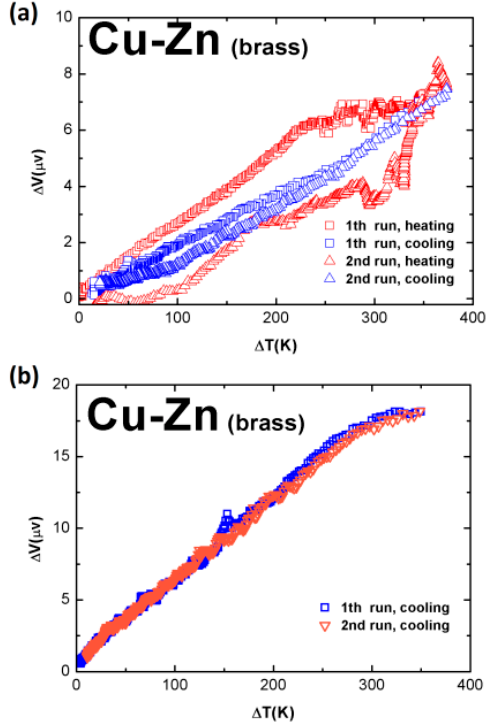
Figure 4. Measurement results of brass wire samples: ( a ) A sample with an original diameter of 2.0 mm; and ( b ) a sample with an original diameter of 1.0 mm. The cross sectional area ratio of the thick arm to the thin, for both samples, is around 3.0.